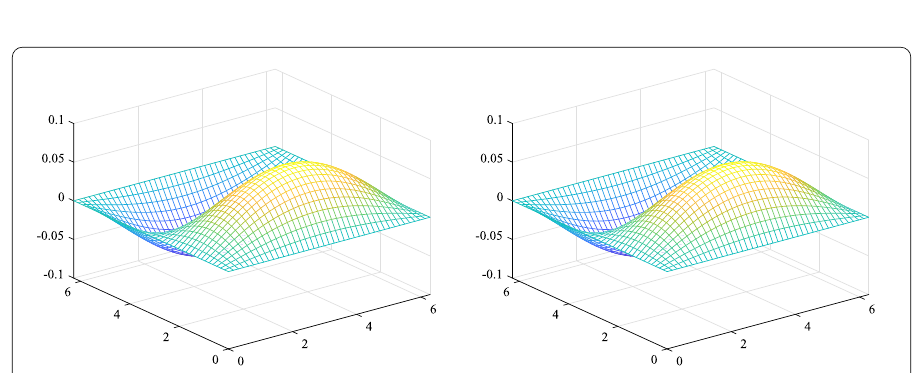
Figure 11 The numerical solution of CFDS6-SSM (left-hand side) and E-CFDS6-SSM (right-hand side) when J = 41, z = 0.4 π and t = 2 for SP 4